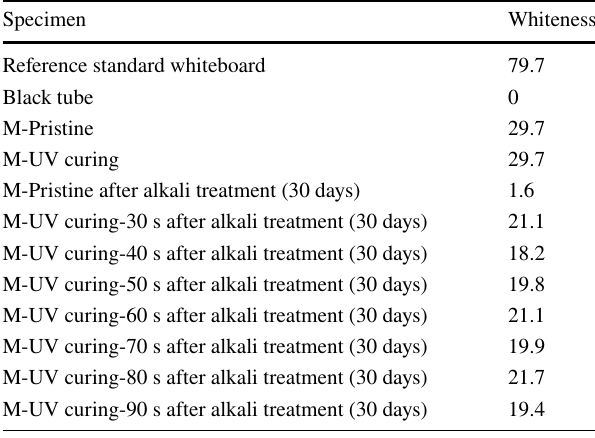
images shown are the respective surfaces in contact with the glass substrate during membrane casting by phase